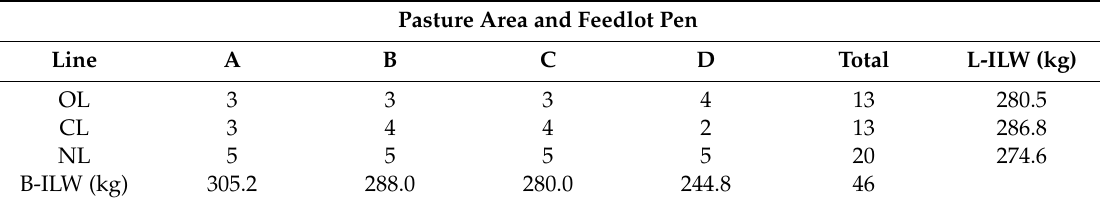
Table 1. Animal arrangement according their line in the pasture areas and feedlot pens, block initial liveweight (B-ILW), and line initial liveweight